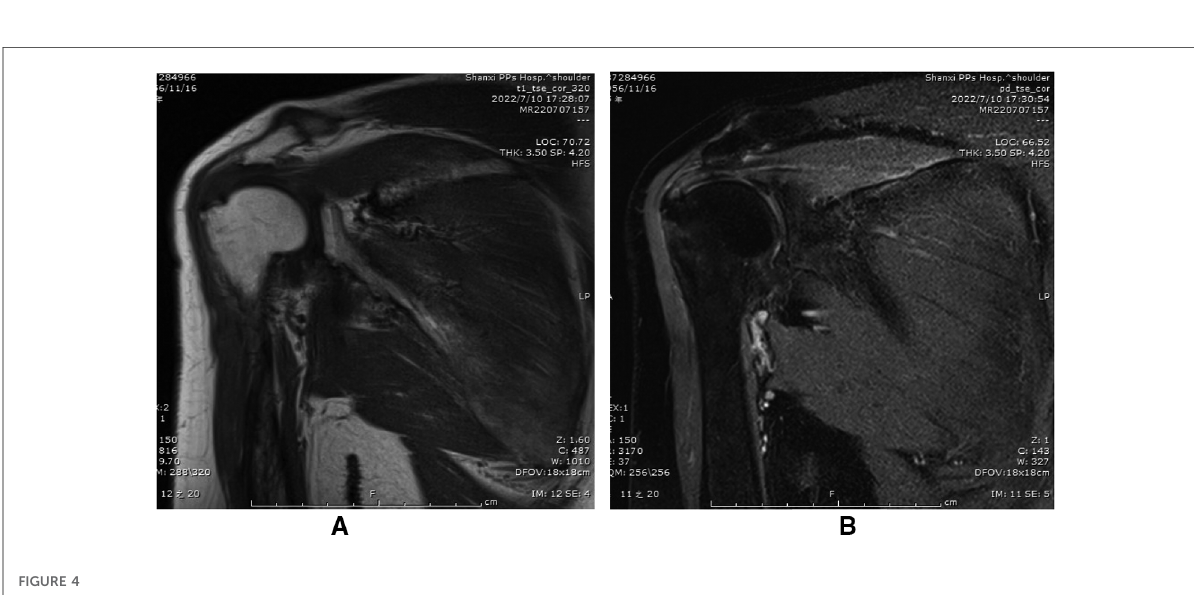
FIGURE 4 Preoperative MRI images: ( A ) calci fi ed foci of supraspinatus tendonitis in preoperative T1WI. ( B ) Calci fi c tendonitis calci fi cations in preoperative T2WI.